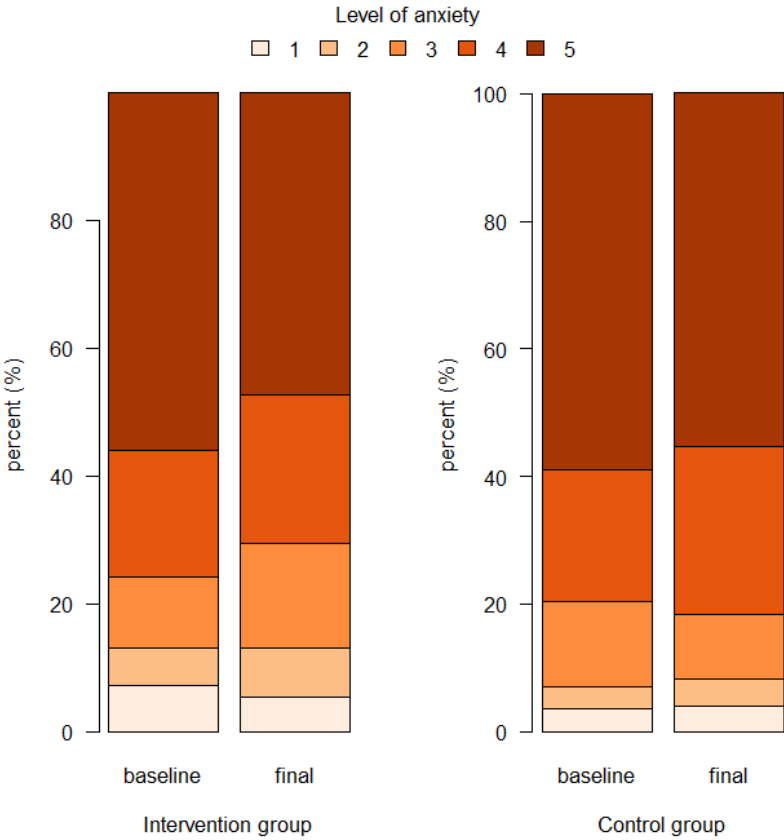
Figure 2. Self-declared baseline and final level of anxiety associated with cancer in intervention and control groups.